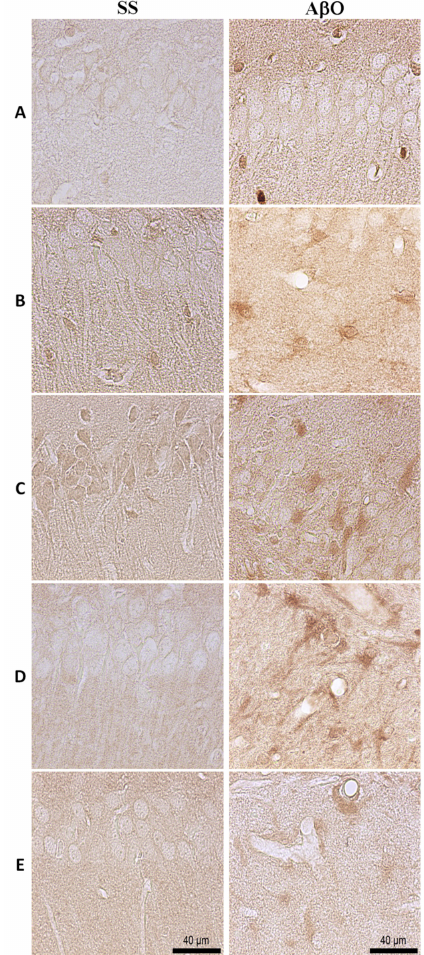
Figure 9. STAT3 expression in the hippocampus. Representative IHC (40 × ) images (scale bar = 40 µ m), show a higher expression of STAT3 mediated by A β O at ( A ) 18 h, ( B ) 72 h, ( C ) 7 d, ( D ) 15 d, and ( E ) 30 d, after microinjection. At 72 h, STAT3 positive cells with glial morphology were identified, with a hypertrophic morphology demarked at day 7 and 15. Some of these cells showed STAT3 nuclear